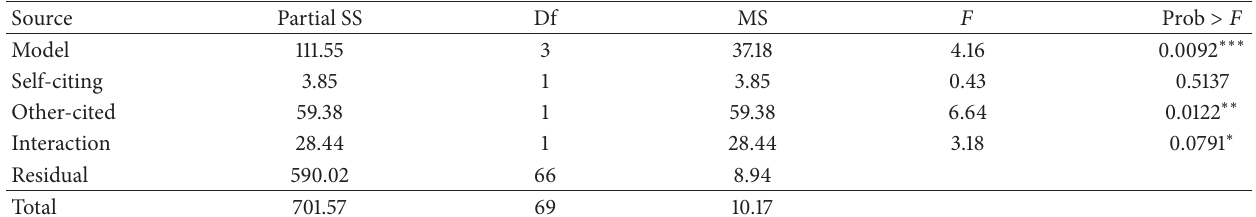
Table 2: Analysis of the variance results for the market-to-book-ratio on self-citing and other-cited citations.